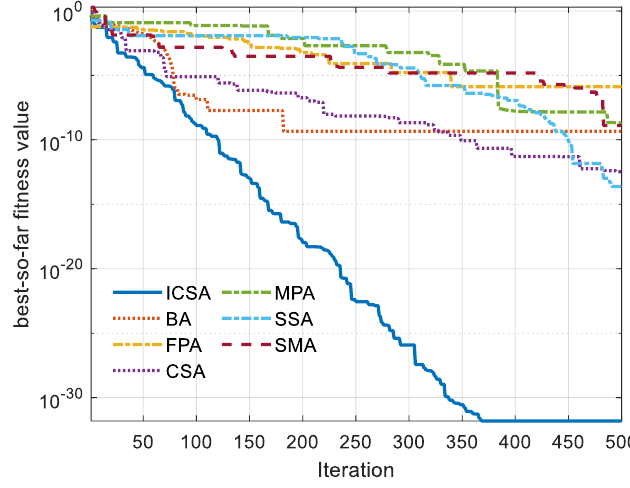
Figure 14. Convergence curve for F14.